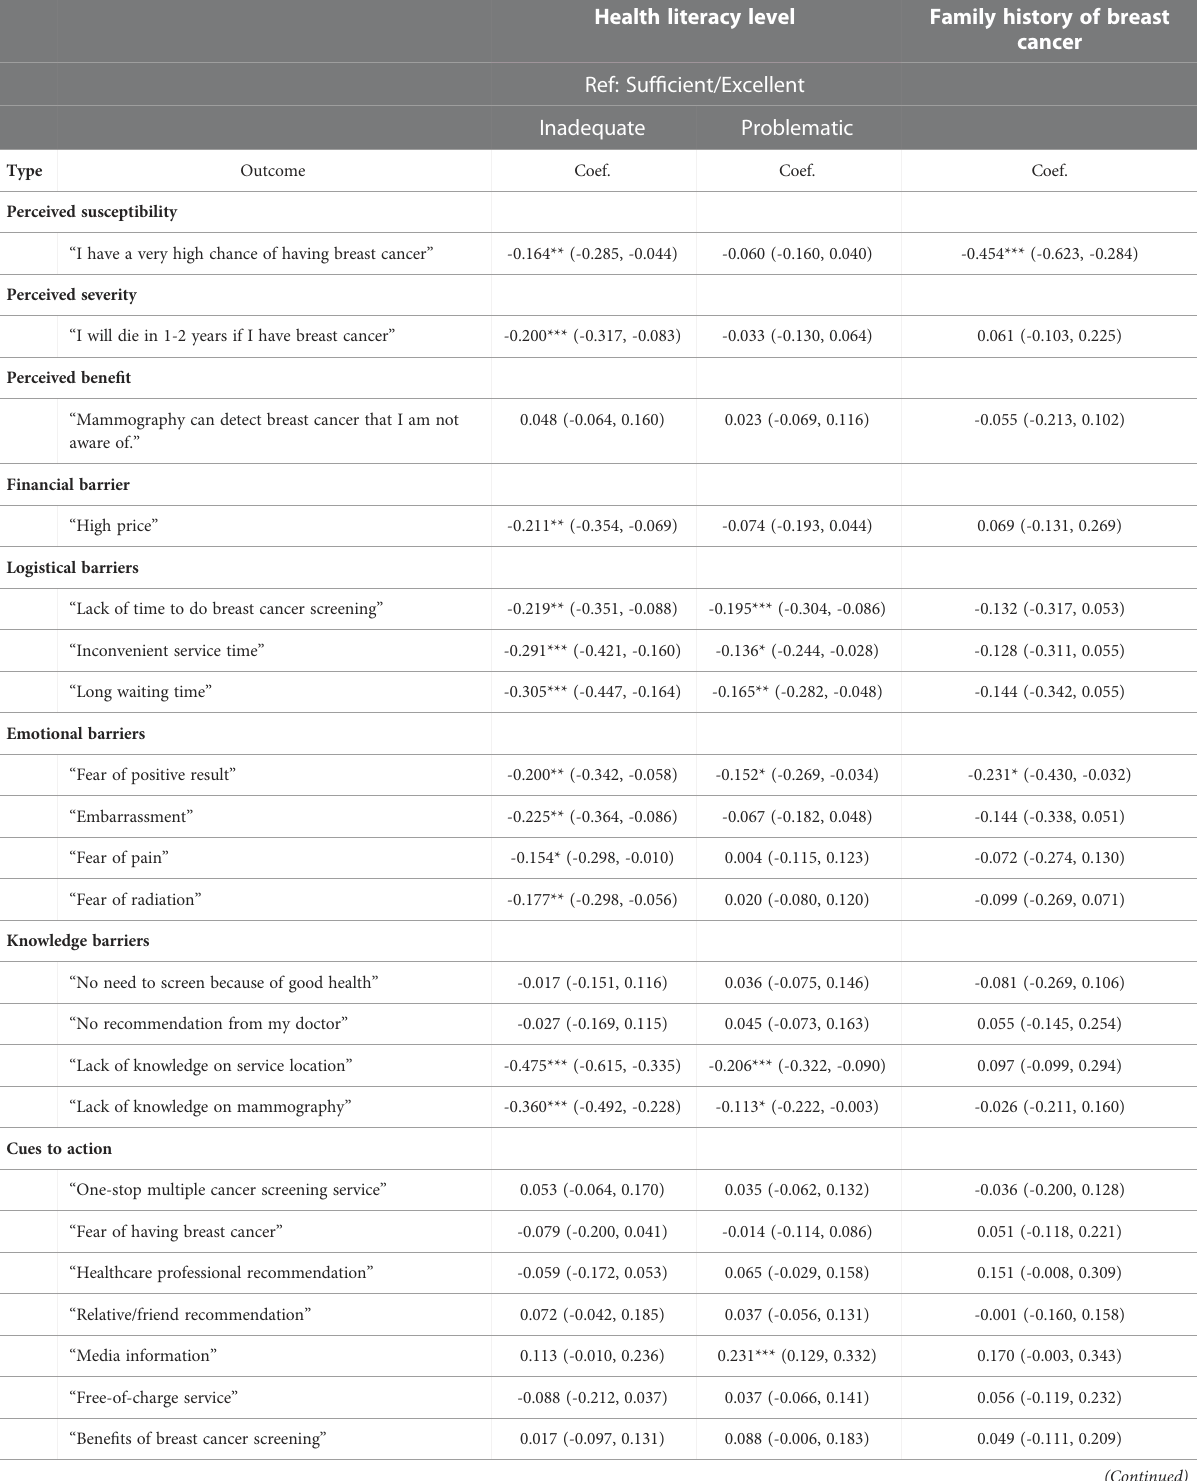
TABLE 3 Associations between screening-related perceptions and health literacy adjusted for covariates #